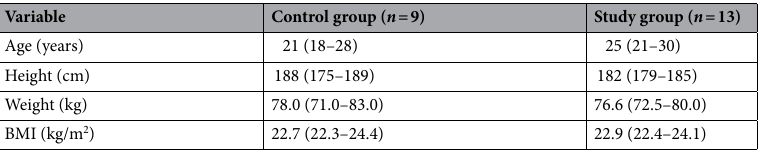
Table 1. The characteristic of the control and study groups of the participants. The table presents median (Q1–Q3) values characterising the participants. BMI body mass index, n number of